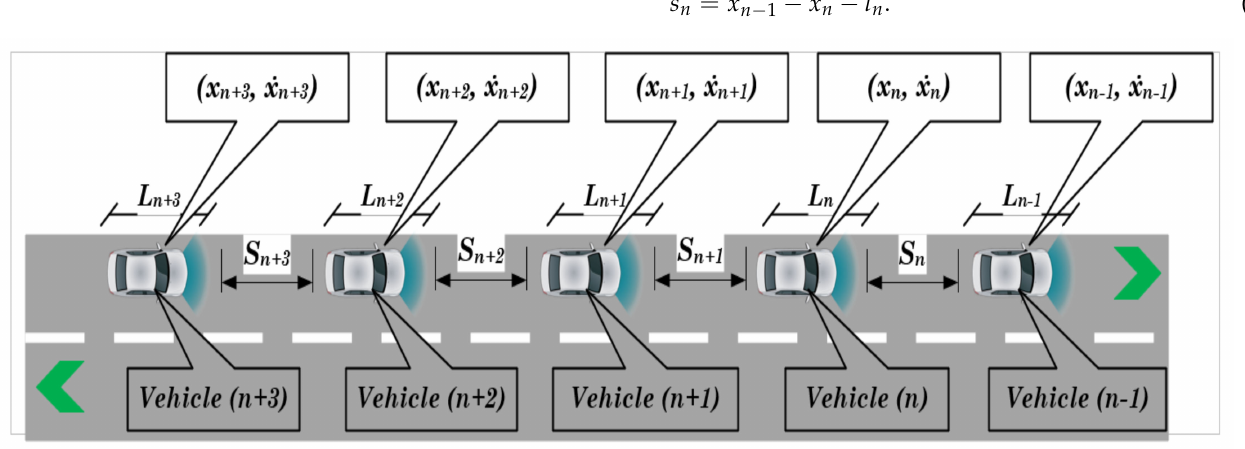
Figure 1. The working of the IDM in physical world environments, incorporating V2V